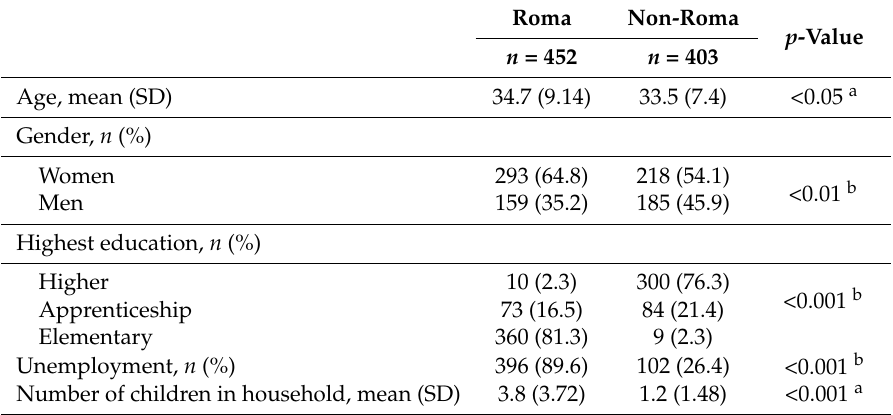
Table 1. Basic characteristics of the Roma and non-Roma samples and p -values for differences between the Roma and non-Roma population in eastern Slovakia. Roma